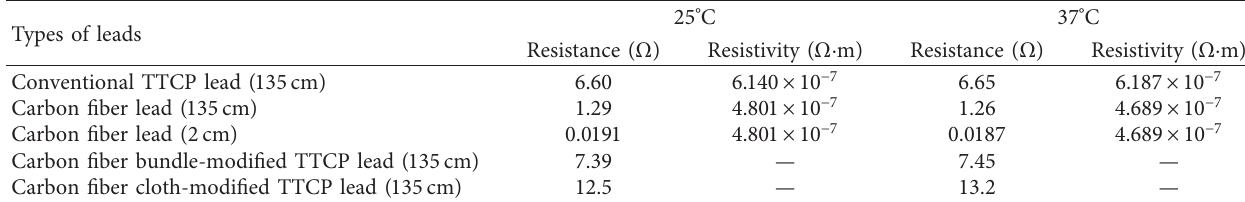
Table 1: Lead resistance measurement